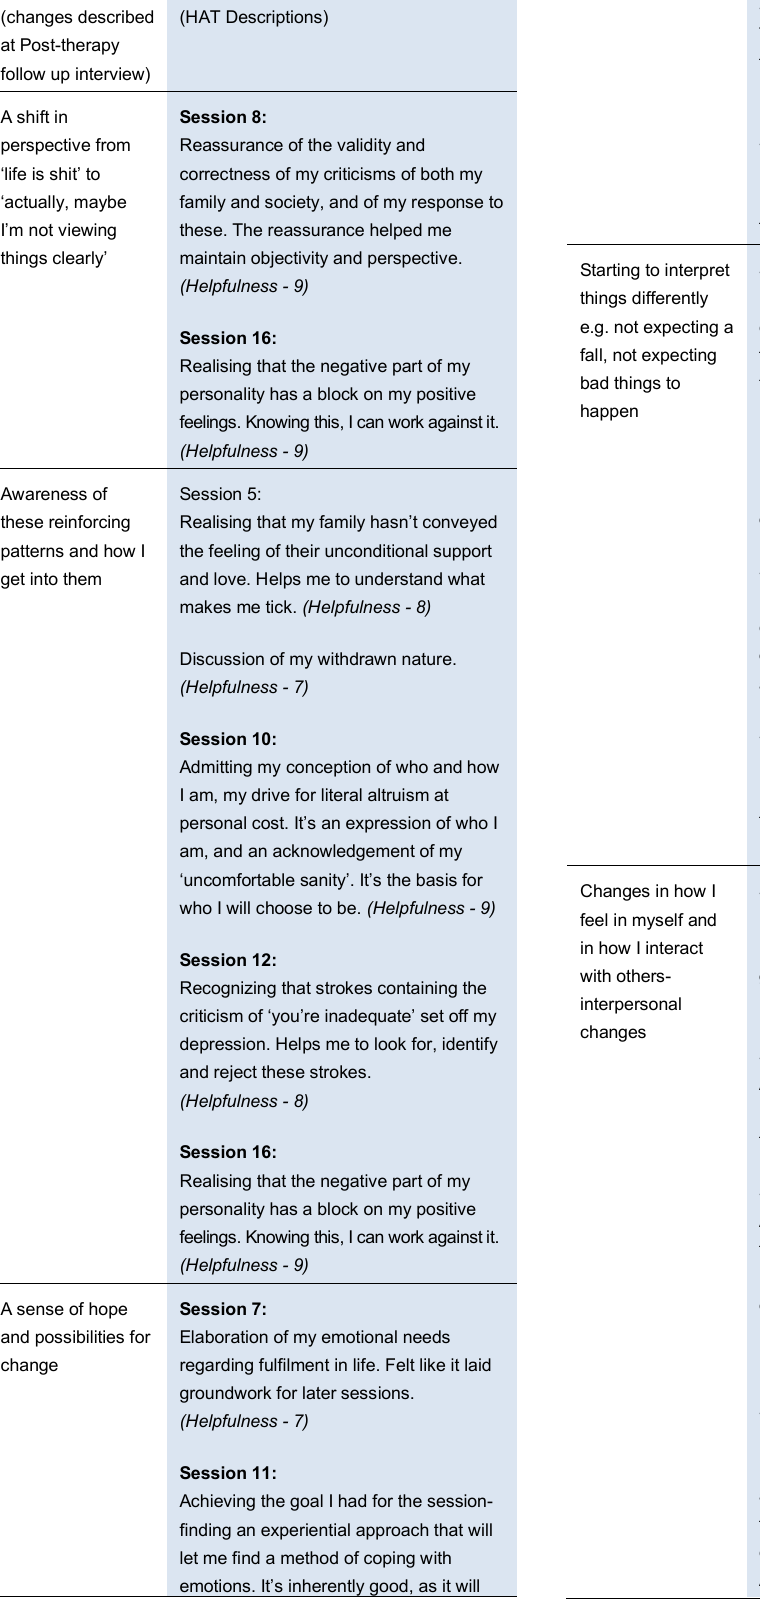
Table B3: Outcome to Process Mapping